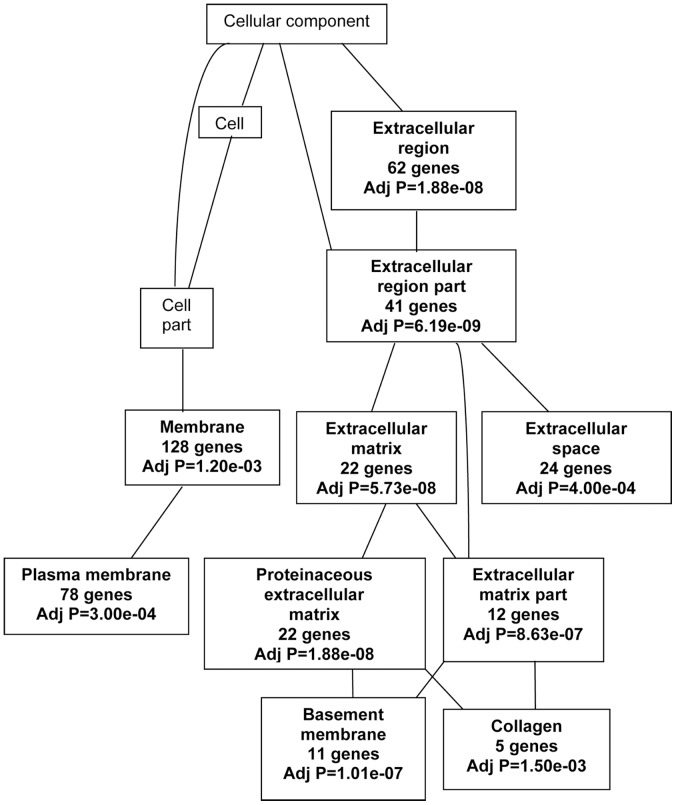
Cellular components related to significantly differentially expressed genes.The differentially expressed genes in all models of DCIS in comparison to MCF10A were analyzed by WebGestalt2 tool. The p-values and the number of differentially expressed genes associated with a particular cellular component are indicated in bold in the respective boxes.